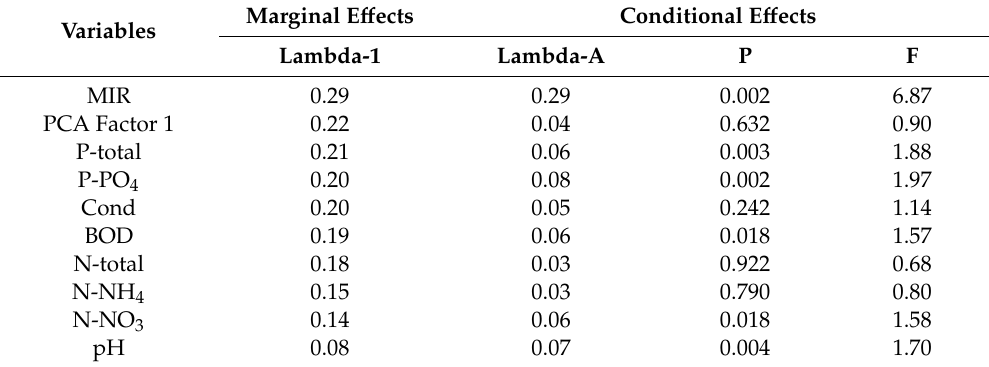
Figure 4. CCA ordination diagram of macrophyte species and environmental variables. Full names of metrics are given in Table 1, and full names of macrophyte taxa are given in Table S2. Table 7. Results of Monte Carlo permutation test of the relationship between species composition and environmental variables.